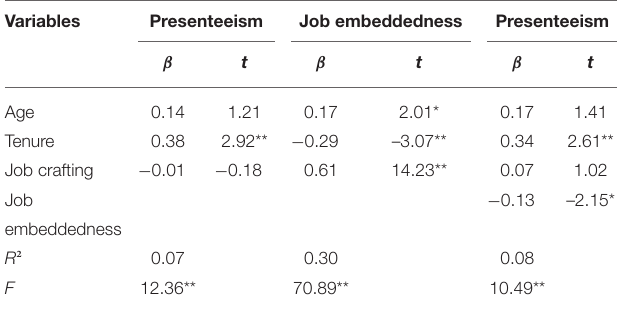
TABLE 3 | Results of the mediation effect of job embeddedness ( n =